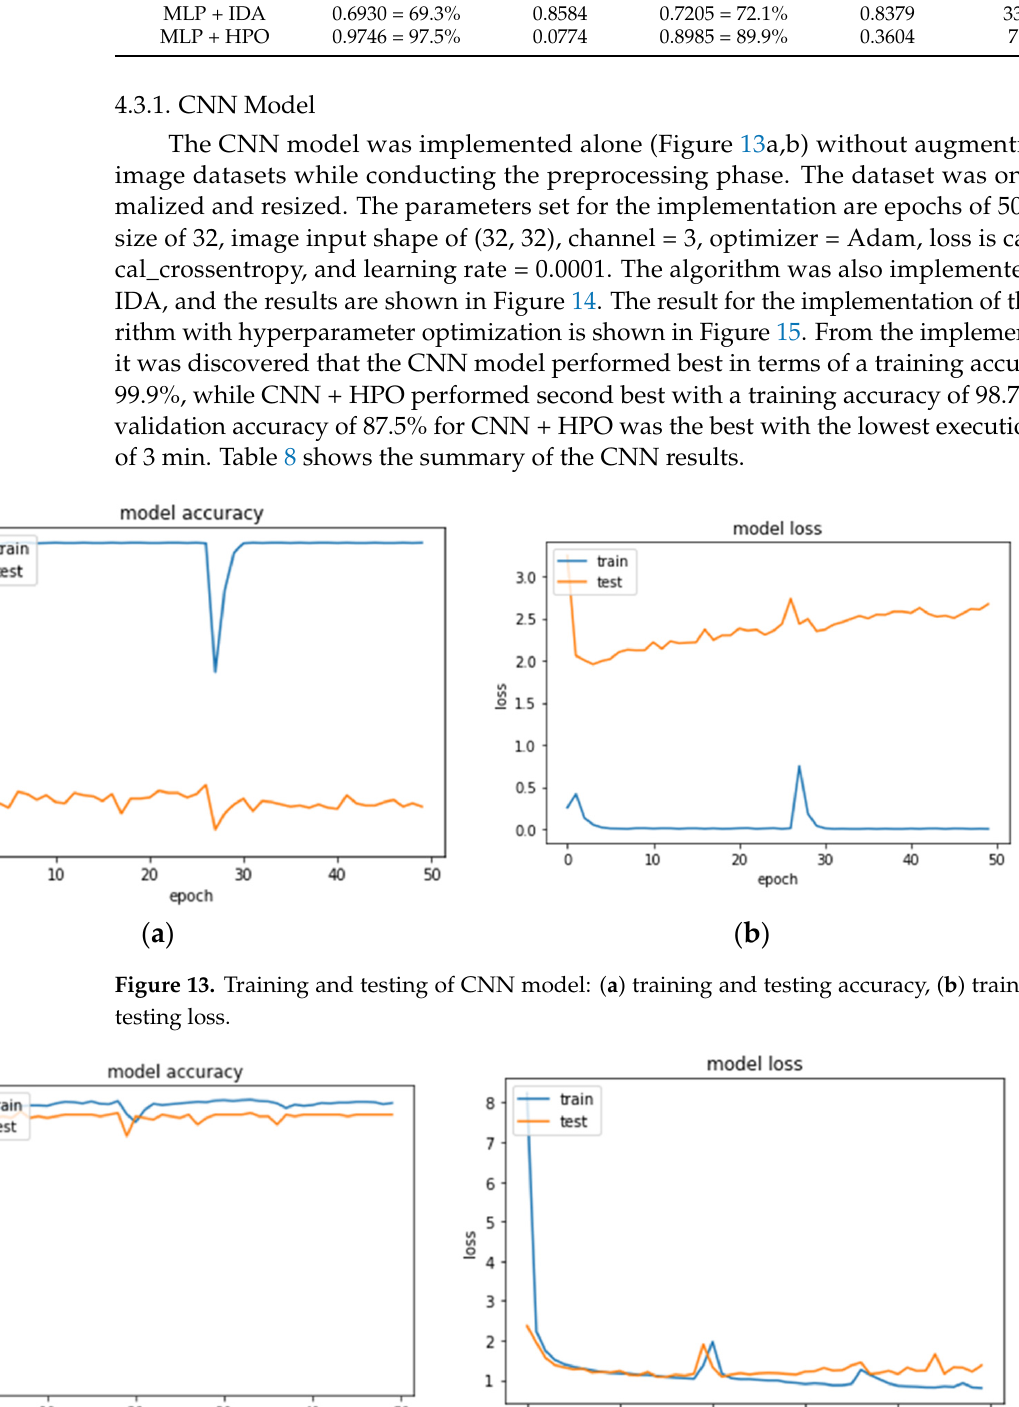
( b ) Figure 15. Training and testing of CNN + HPO model: ( a ) training and validation accuracy, ( b ) training and validation loss. 4.3.2. MLP Model Figure 16, Figure 17, and Figure 18 give the MLP classifier alone result, with image augmentation, and with the hyperparameter optimizer, respectively. The MLP algorithm